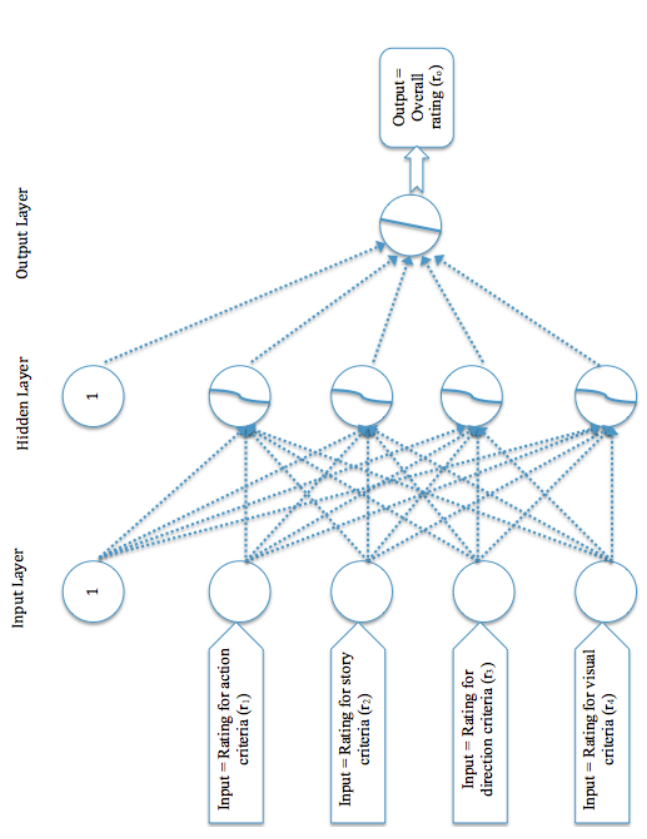
Figure 1. Architecture of the basic multi-layered neural